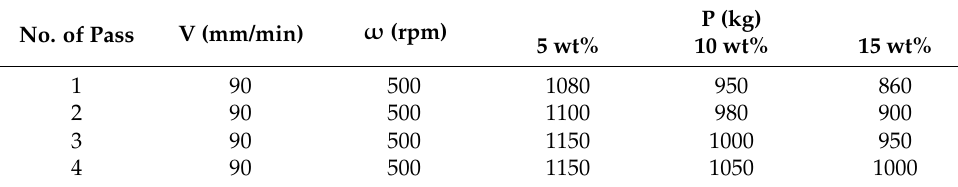
Table 2. Friction stir processing parameters for workpieces with 5, 10, 15 wt% Mo content. No. of